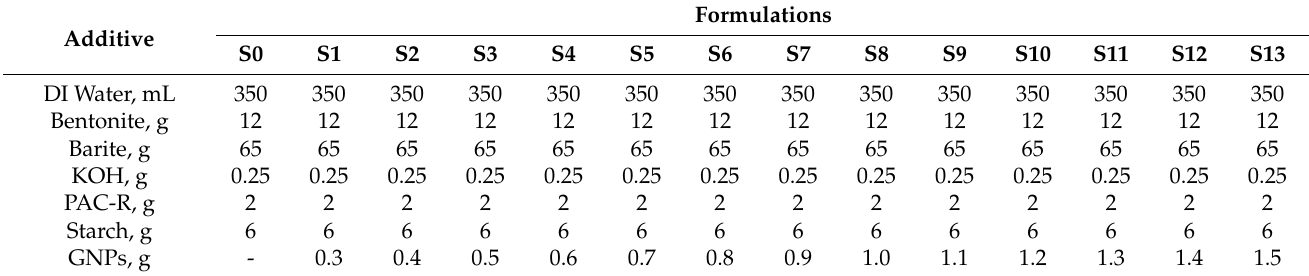
Table 3. Drilling fluid